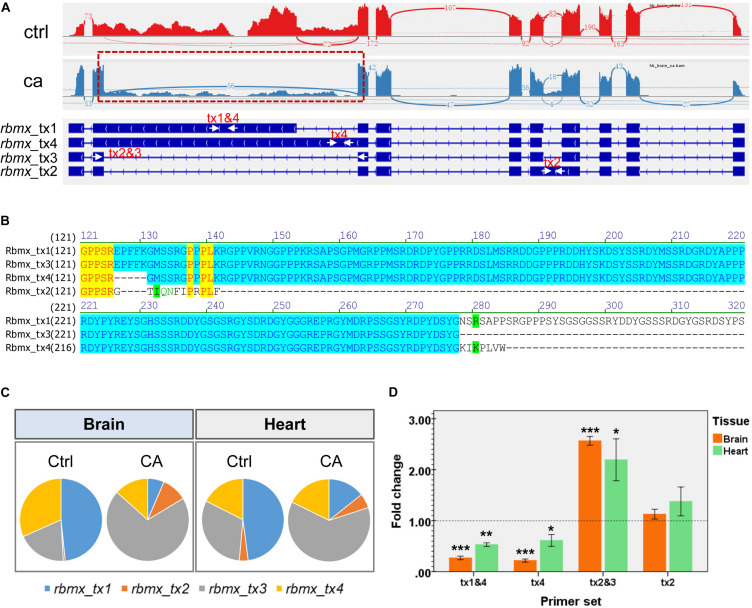
Cold-induced alternative splicing of the common carp rmbx gene. (A) Transcripts of the HB carp rmbx gene are displayed and the Sashimi plot indicates the number of reads split across the junctions. The arrows indicate primers used for qPCR assays to detect the abundance of transcripts. (B) Alignment of the peptide sequences encoded by the transcripts of carp rbmx gene. The identical N-terminals (1–125 amino acids) are shown in yellow. These peptides have identical N terminals and different C terminals. (C) Ratio of transcript abundances under control and cold acclimation conditions. (D) qPCR validation for the cold-induced alternative splicing of carp rbmx gene in tissues of the HB strain. Data are means ± SD (n = 3); *p < 0.05; **p < 0.01; ***p < 0.001.